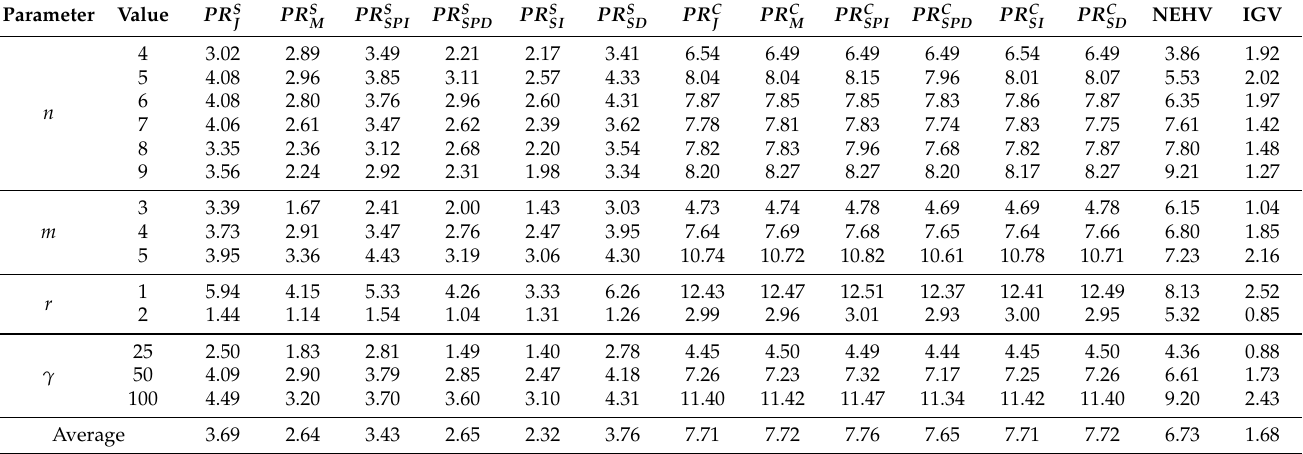
Table 4. Computational results in small-sized instances: ARPD values of the proposed decoding procedures, the best NEHV (i.e., NEHV(PMS,ABS,D)), and